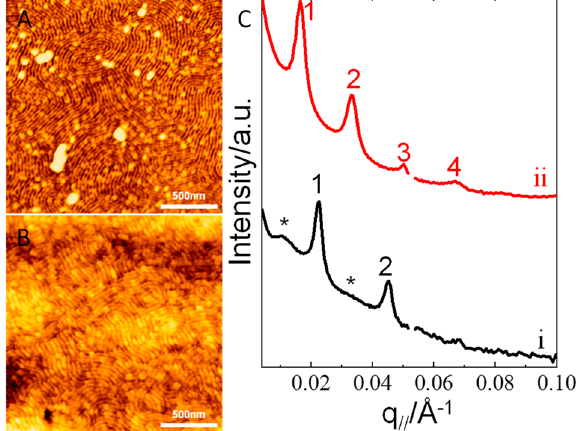
Figure 6. ( A , B ) 2 × 2 µm 2 AFM topographies and ( C ) 1D in-plane GISAXS profiles of thin films (h i = 17 nm on PS 270n -SiO x /Si) of neat P(S-b-MMA) BCPs of various molecular weight: ( A , C i ) P(S 21 -b-M 21 ) and ( B , C ii ) P(S 33 -b-M 33 ). The films were annealed at 230 °C (1 h) and treated by a combination of UV-light exposure (2.5 h) and acetic acid rinsing. In curve − C i , broad humps corresponding to the scattering of wrinkles are marked by black asteroids (*). The positions of the diffraction truncation rods are labelled by q // ratios.